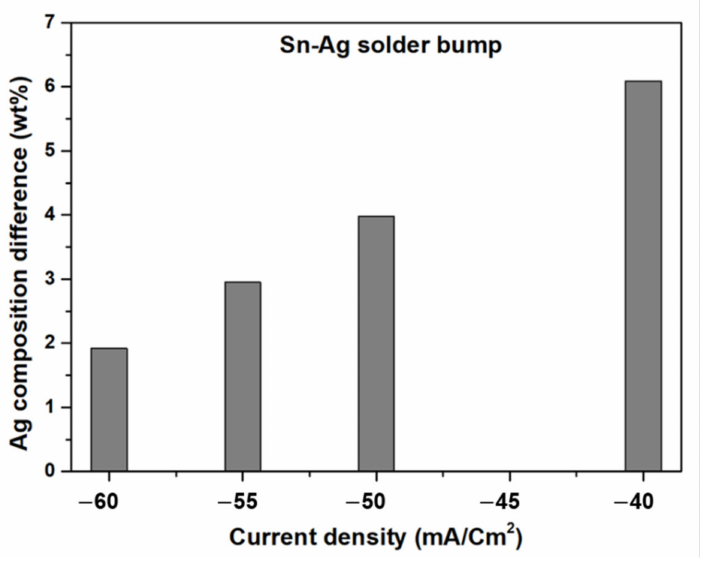
Figure 17. Ag composition difference on the top and bottom of the Sn-Ag solder bump, data adapted from Ref.